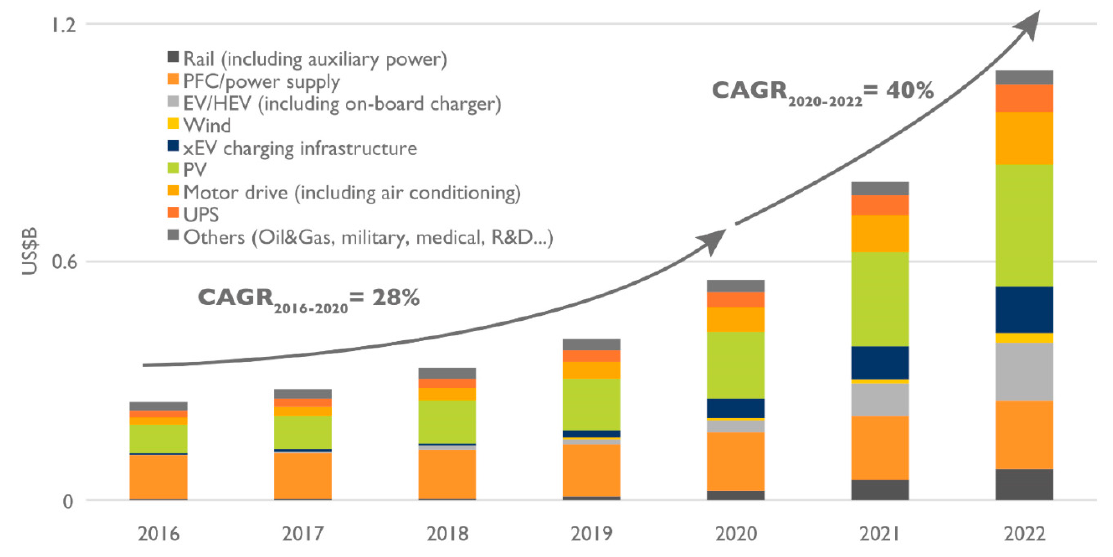
Figure 27 . Chart showing the market capitalization of SiC-based devices for various applications [92].